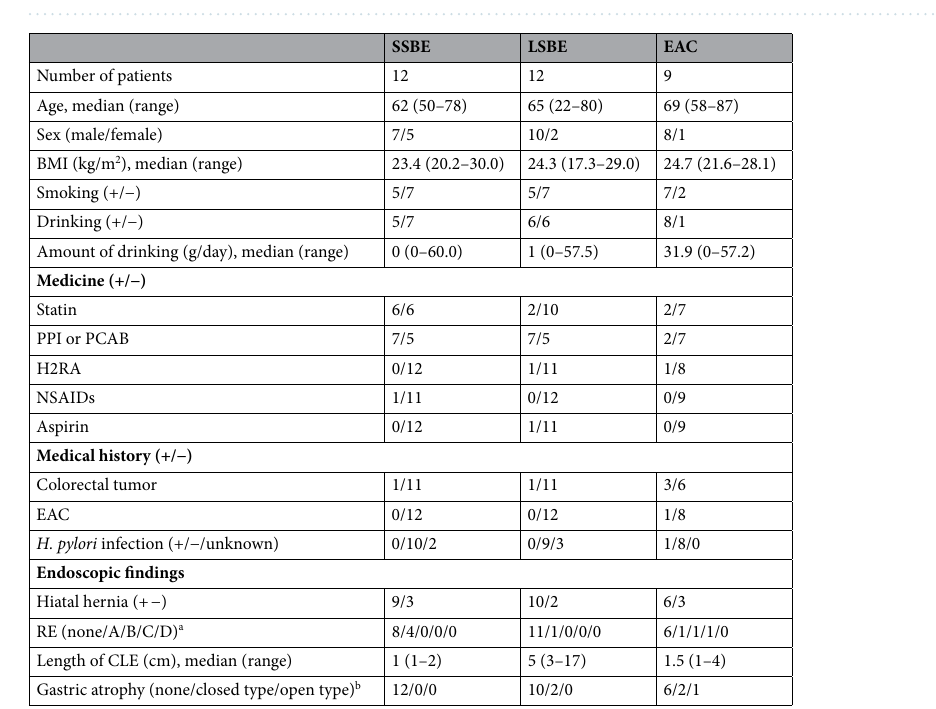
Figure 3. Study flow. EAC esophageal adenocarcinoma, EMR-C endoscopic mucosal resection with cap, ESD endoscopic submucosal dissection, LSBE long-segment Barrett’s esophagus, SSBE short-segment Barrett’s esophagus.